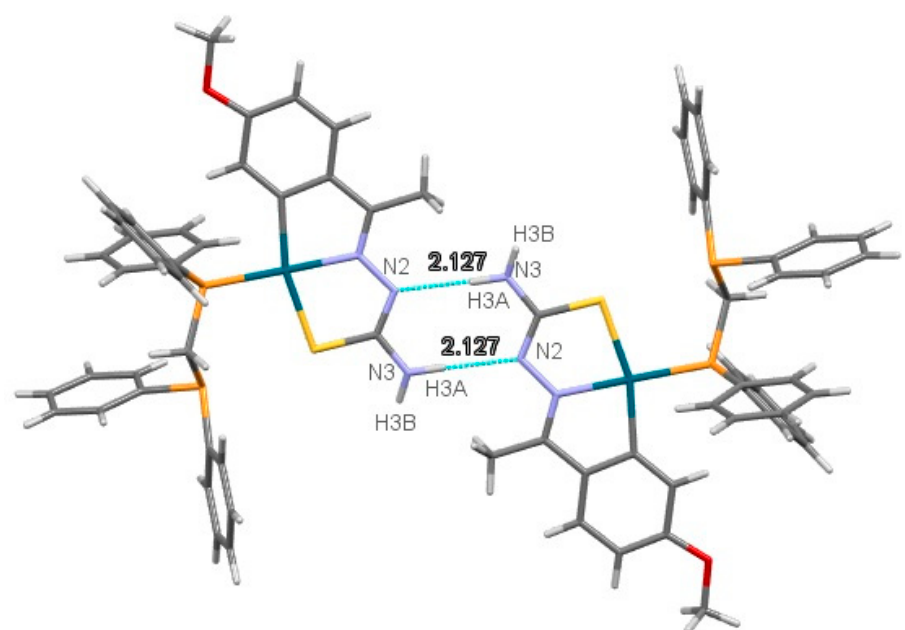
Figure 5. Intermolecular hydrogen bonding interaction in 1c